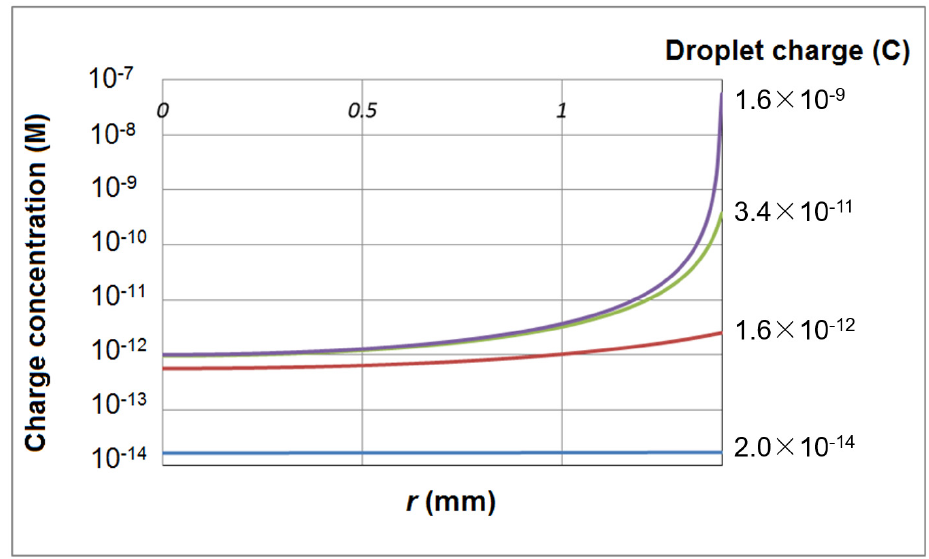
Figure 2. Calculated dependencies of the volume concentration of elementary charges on the distance from the center of the droplet. The droplet diameter is 2.8 mm (accordingly, its radius is r 0 = 1.4 mm). The dependencies shown in Figure 2 indicate that at low volume concentration of elementary charges, they do not interact with each other, and their distribution over the droplet volume is approximately uniform. With increasing the total charge borne by the drop, the majority of the charges is distributed in the surface layer owing to the influence of electrostatic repulsion. At greater ( ≥ 10 − 11 C) total charge of the droplet, the concentration of elementary charges in bulk virtually does not exceed the value of 6 × 10 14 e /m 3 (here, e = 1.6 × 10 − 19 C), while their vast majority accumulates at the periphery of the droplet. Thus, the concentration of charges in the bulk of the droplet (apart from its near-surface layer) does not exceed ~10 − 11 moles of electrons per